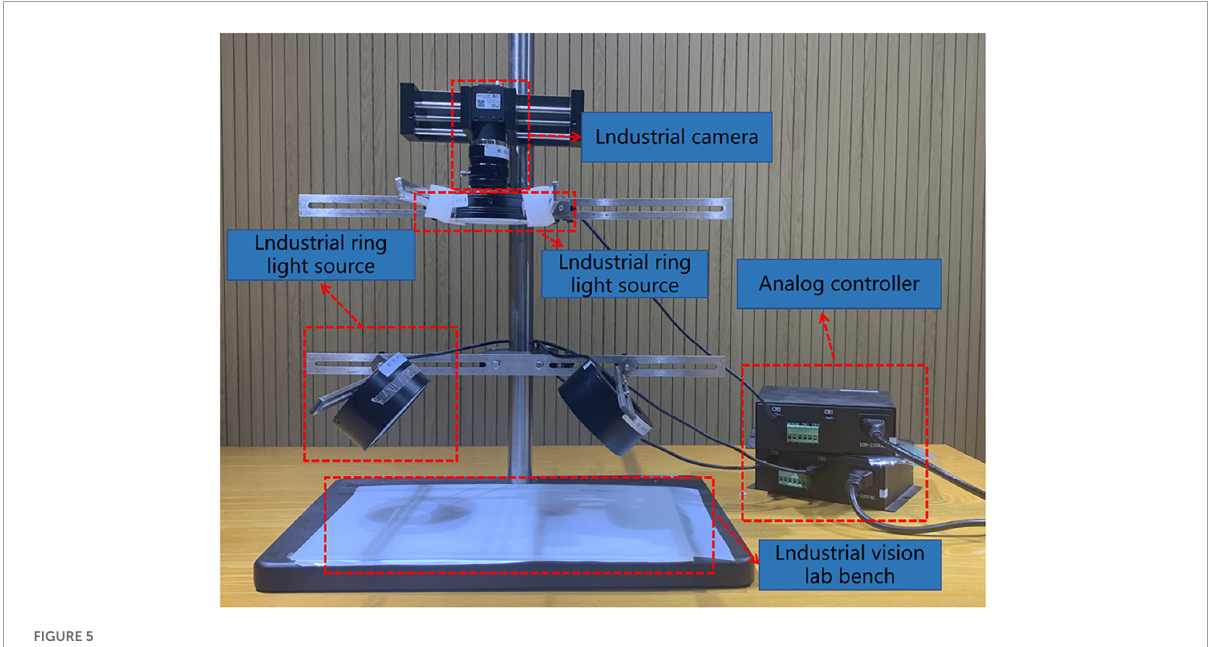
FIGURE5 Visual motor